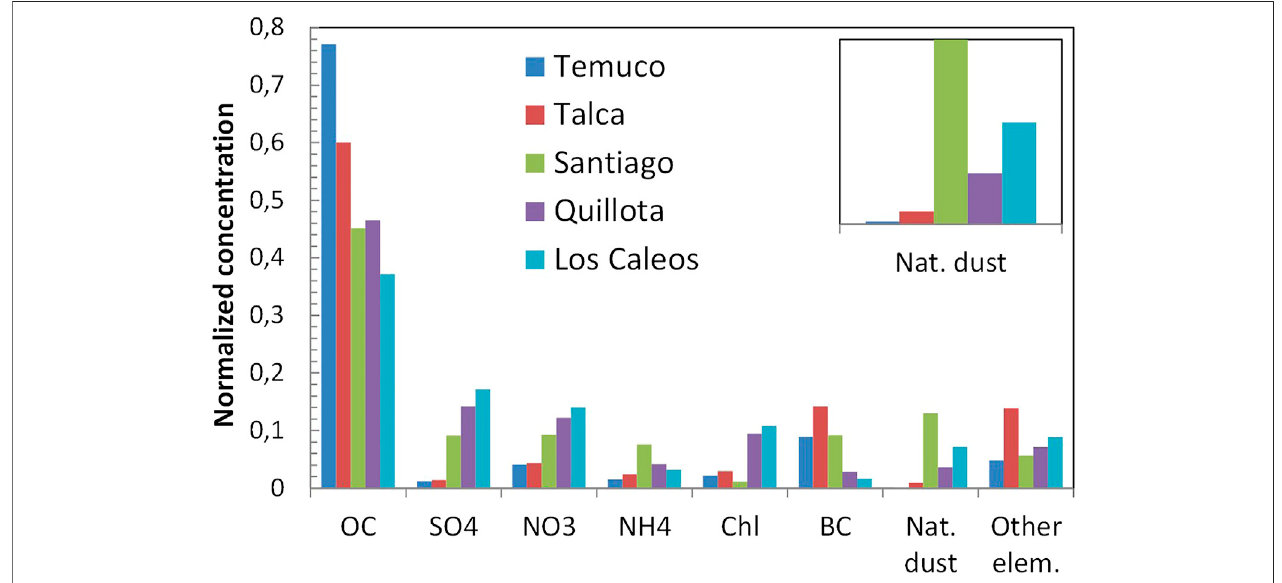
FIGURE 8 | Normalized chemical composition of PM 2.5 in the fi ve cities. The order of the cities is from south to north. The inset shows a larger view of the natural dust concentration.